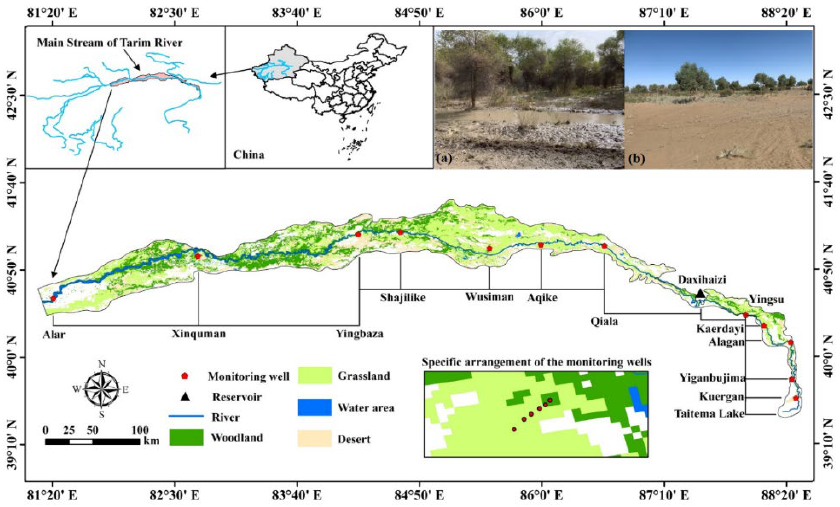
Figure 1. Overview of the study area. ( a ) is the ecological water conveyance in the Populus euphratica forest area, and ( b ) is the ecological water conveyance in the sparse vegetation area.